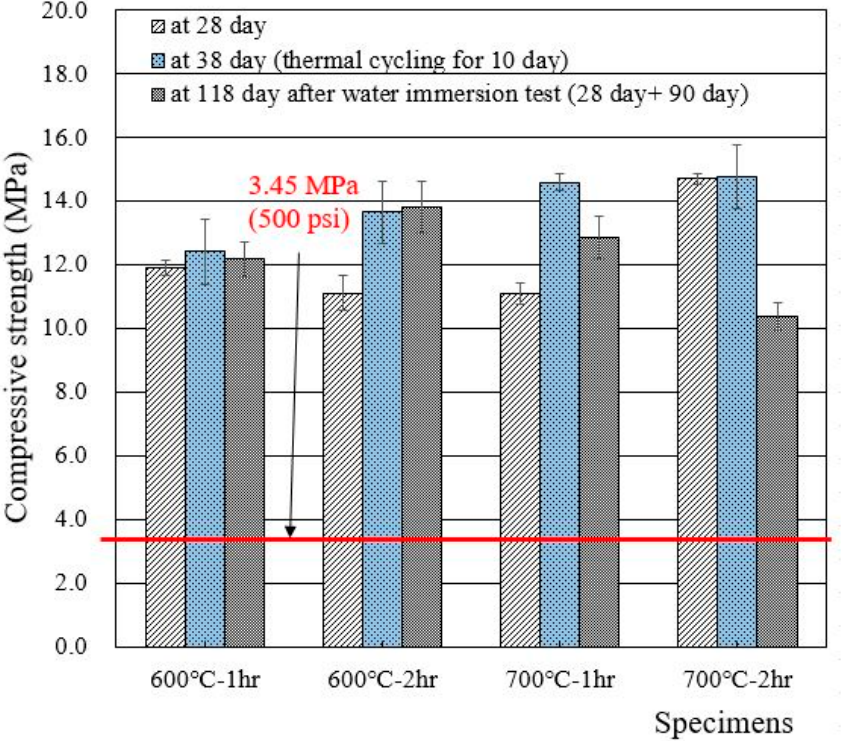
Figure 6. Compressive strengths of wasteform specimens made of 1 M CsCl and recycled cement powder heat treated at 600 and 700 °C.